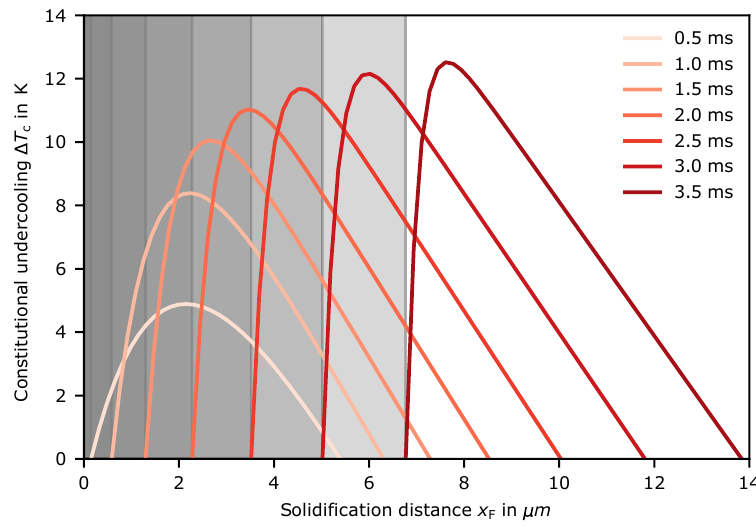
Figure 9. Constitutional undercooling ∆ T c over several times ahead of the solidification